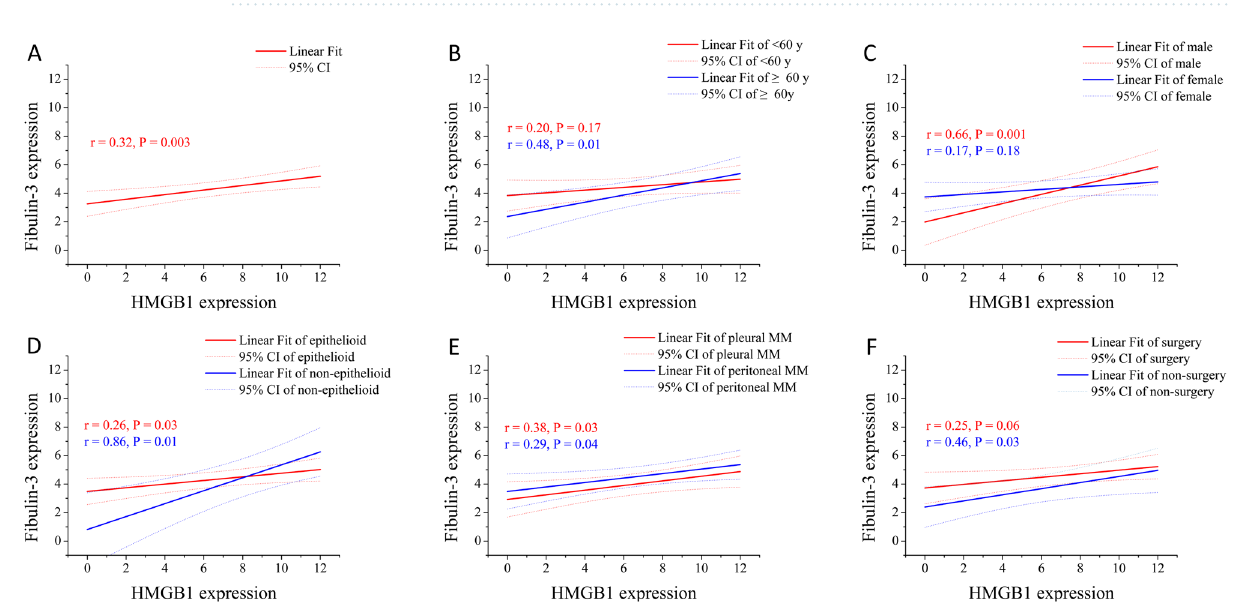
Figure 3. Fitting lines and 95% confidence intervals of fibulin-3 and HMGB1 expression. ( A ) Overall fitting line and 95% confidence intervals between fibulin-3 and HMGB1 expression. ( B ) Fitting line and 95% confidence intervals between fibulin-3 and HMGB1 expression in different genders. ( C ) Fitting line and 95% confidence intervals between fibulin-3 and HMGB1 expression in different ages. ( D ) Fitting line and 95% confidence intervals between fibulin-3 and HMGB1 expression in different subtypes. ( E ) Fitting line and 95% confidence intervals between fibulin-3 and HMGB1 expression in different sites. ( F ) Fitting line and 95% confidence intervals between fibulin-3 and HMGB1 expression in different